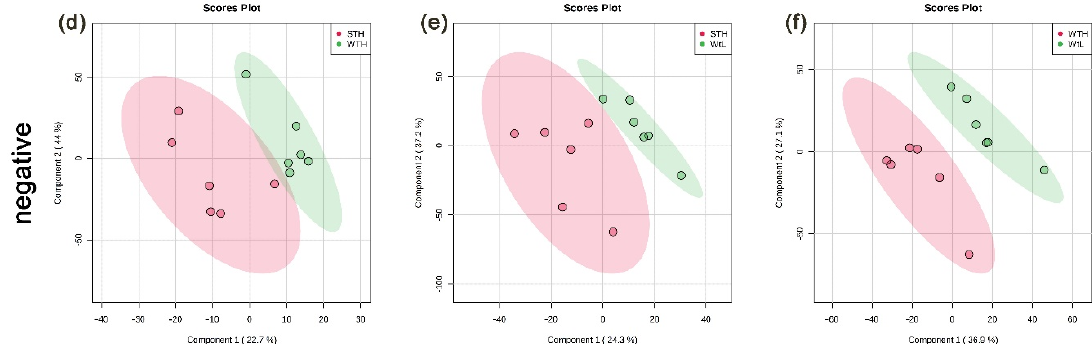
Figure 1. Partial least squares-discriminant analysis (PLS-DA) model of uterine fluid metabolites. ( a – c ) PLS-DA score plots of uterine fluid samples collected from hens with STH, WTH, and WtL eggshells in positive ion mode; ( d – f ) PLS-DA score plots of samples collected with negative ion mode. Each point in the graph represents one sample, and the discretization of the two-color symbols represents the distribution of the two sets of samples on the PC1 and PC2 axes. STH, hens with strong, thick, and heavy eggshells; WTH, hens with weak, thick, and heavy eggshells; and WtL, hens with weak, thin, and light eggshells.